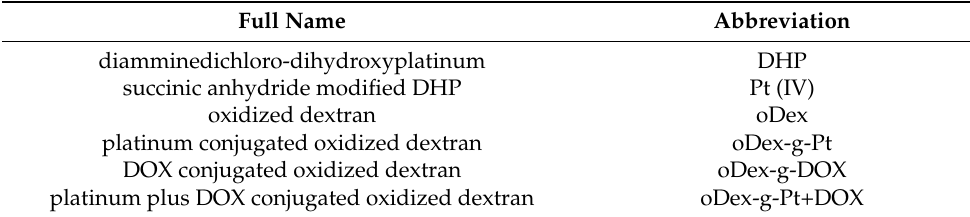
Table 1. The full name and corresponding abbreviation for the synthesized molecules and polymers.